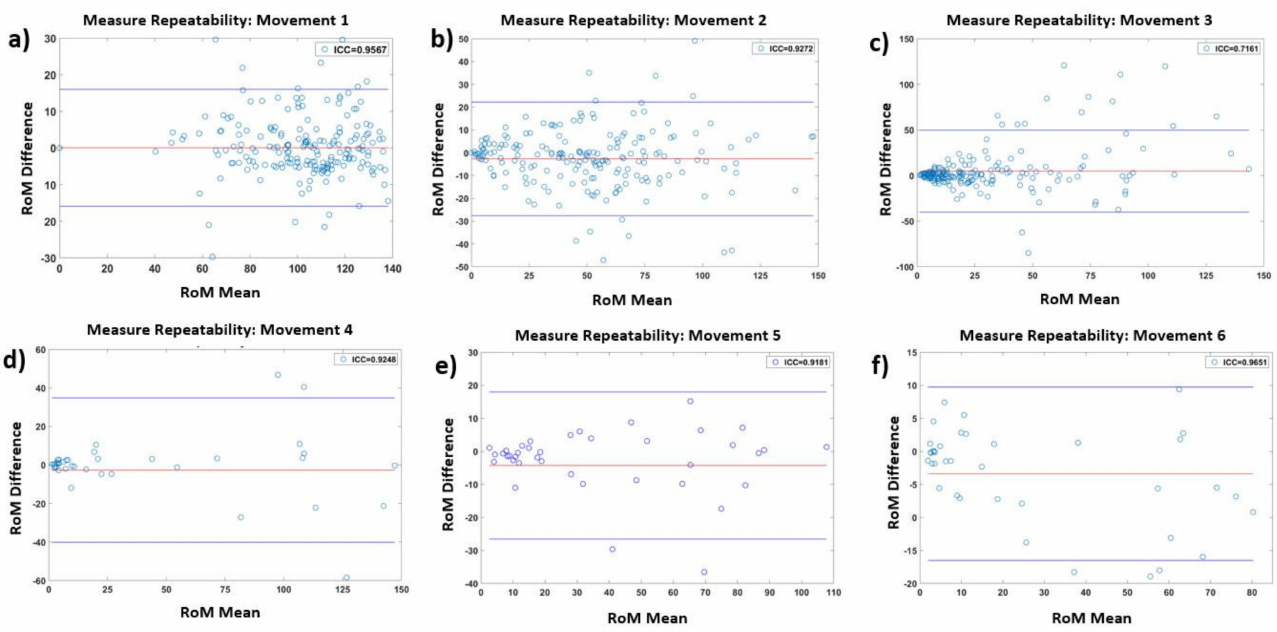
Figure 6. Bland–Altman plots presenting the mean difference plots showing the agreement between the two repeated measurements of the ranges of motion of the inertial measurement units placed along the subjects’ back and head for the six movements: ( a ) anterior hip flexions; ( b ) trunk lateral flexions; ( c ) trunk axial rotations; ( d ) cervical axial rotation; ( e ) cervical flexion/extension; ( f ) cervical lateral